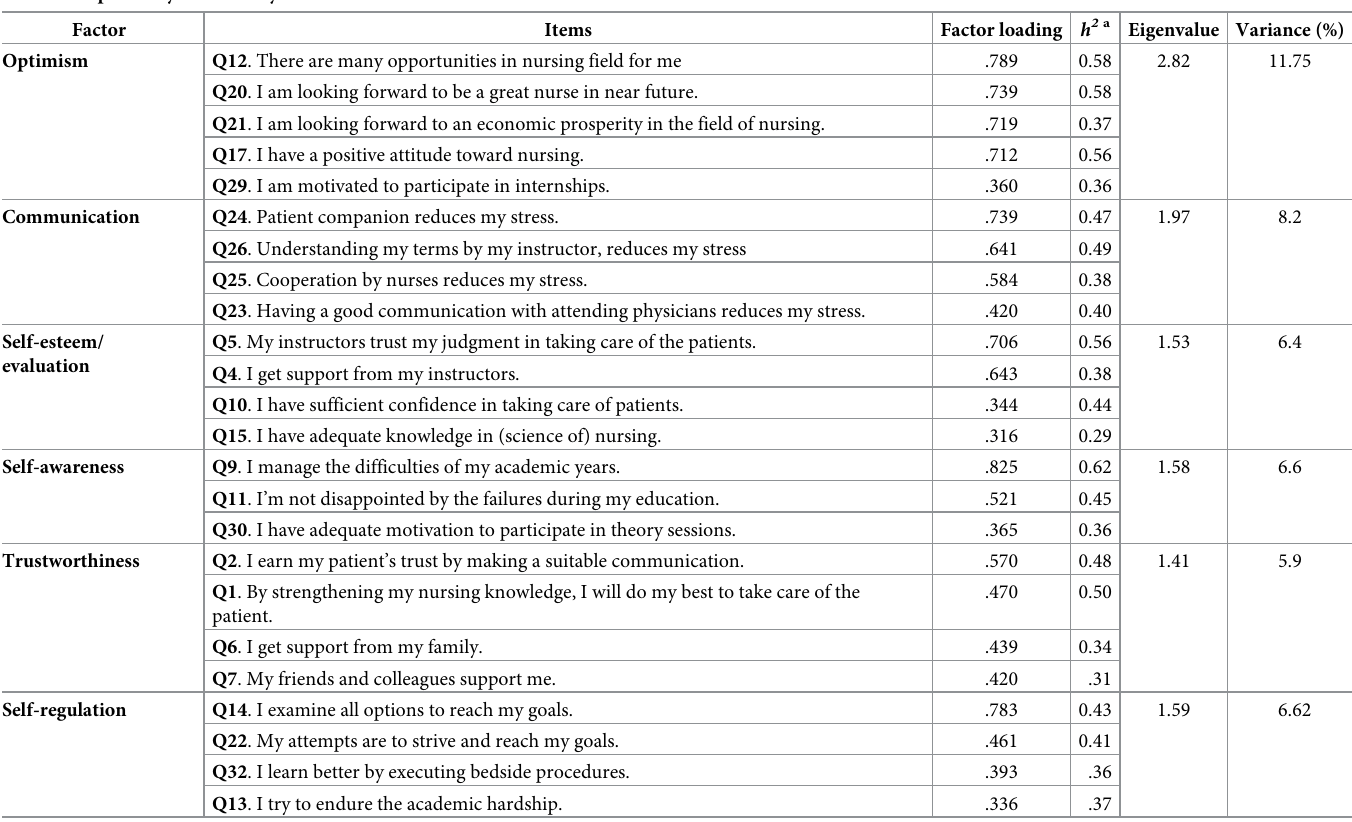
Table 2. Exploratory factor analysis of the NSARI.